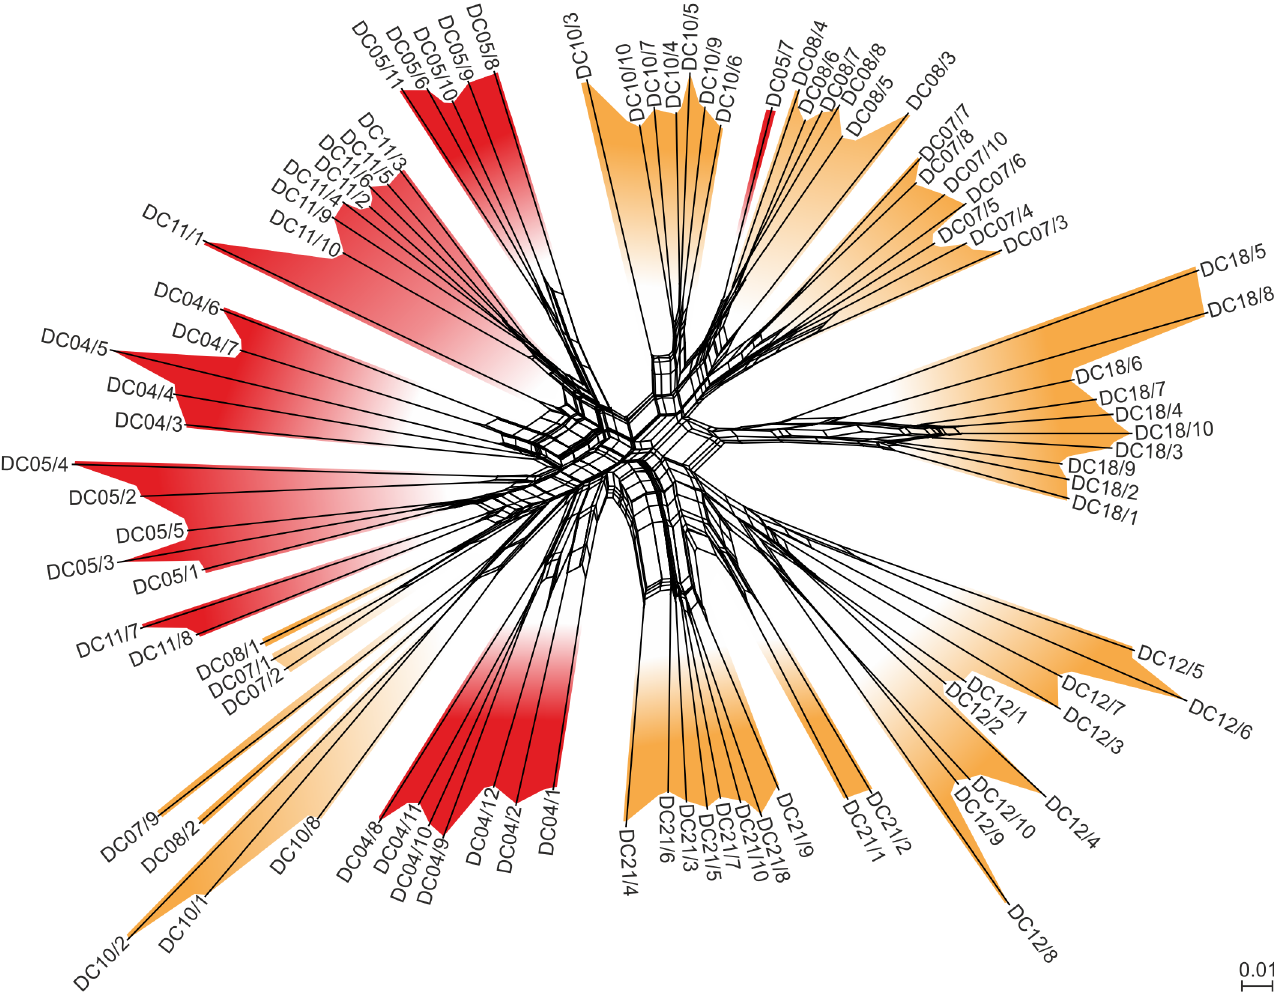
Fig 3. NeighborNet of Lake Donggi Cona Radix specimens based on AFLP data. Lake specimens are colored in red; drainage specimens in orange. For specimen and locality details see the Supplement (S1